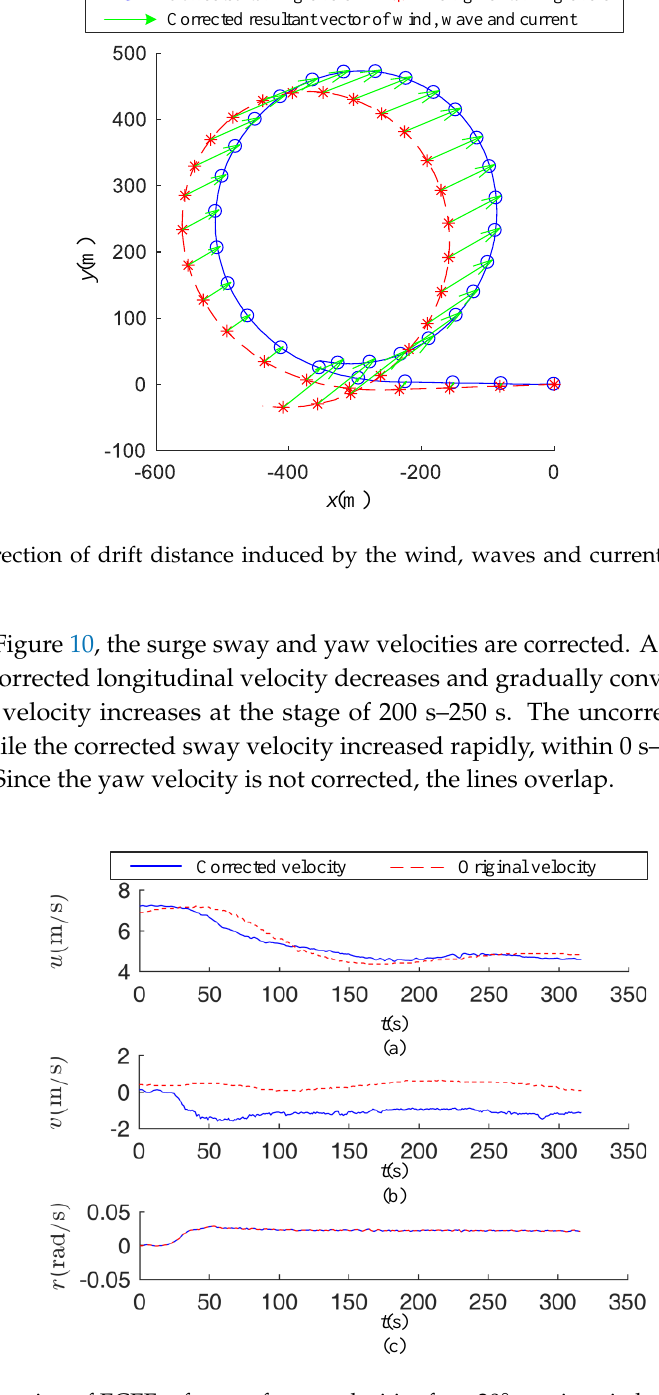
Figure 10. Correction of ECEF reference frame velocities for +20° turning circle test. ( a ) Ship surge velocity; ( b ) ship sway velocity; ( c ) ship yaw velocity.